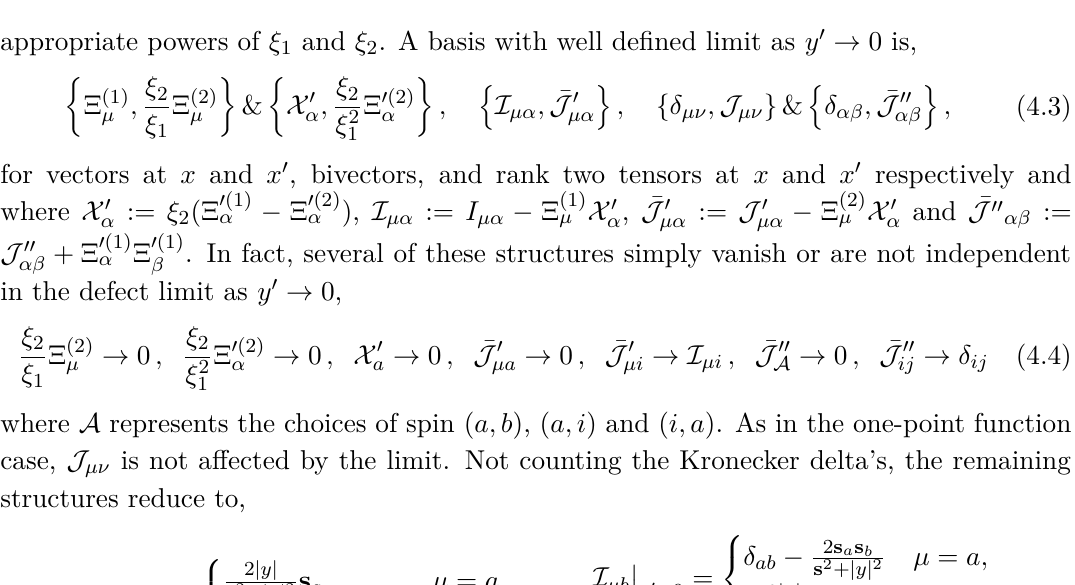
Table 3 . List of independent tensor structures used to construct bulk-to-defect two point corre- lation functions. The definition of these structures can be found in (4.5) where we use a hat on the bulk tensor structure to indicate it being evaluated at y 0 = 0 . For a bulk-to-defect two point correlation function, the tensor structures at x can have bulk Lorentz spin while the structures at x 0 can either have parallel and/or orthogonal spin. Likewise, a bivector at ( x, x 0 ) will have one bulk spin and one parallel or orthogonal spin. Hence we separate the spin combinations in this